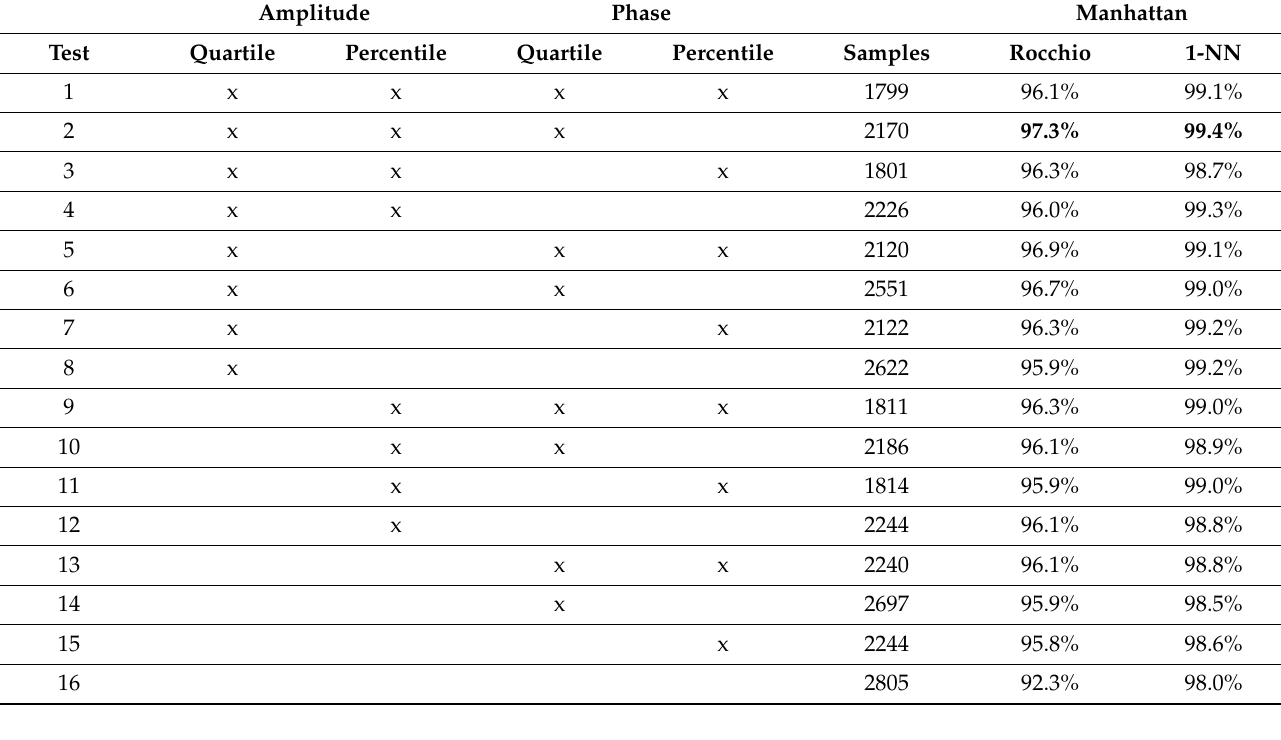
Table 2. Sixth scenario results for Rocchio and 1-NN with Manhattan and outlier selections.